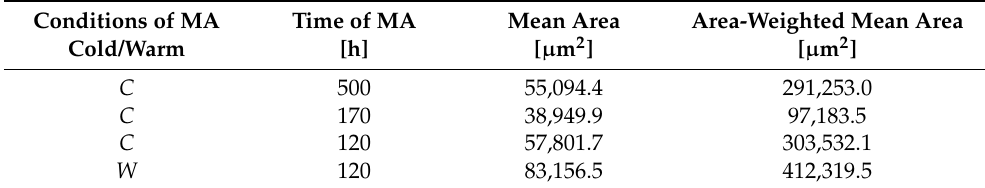
Figure 7. Representative IPF-Z EBSD maps of the unfavorable grain microstructures of ( a ) C 90 and ( b ) C 60. The grain microstructure in ( a ) is not fully recrystallized with a large amount of non- indexed regions, where the grains are either too small or the extreme dislocation density prevents the formation of pronounced Kikuchi patterns. The grain microstructure in ( b ) is better developed than in ( a ); however, the grains are small and thus unfavorable towards high-temperature strength. Table 2. Grain size analysis of consolidated recrystallized powders. The batches C 60 and C 90 are not presented, as the recrystallization is incomplete in the